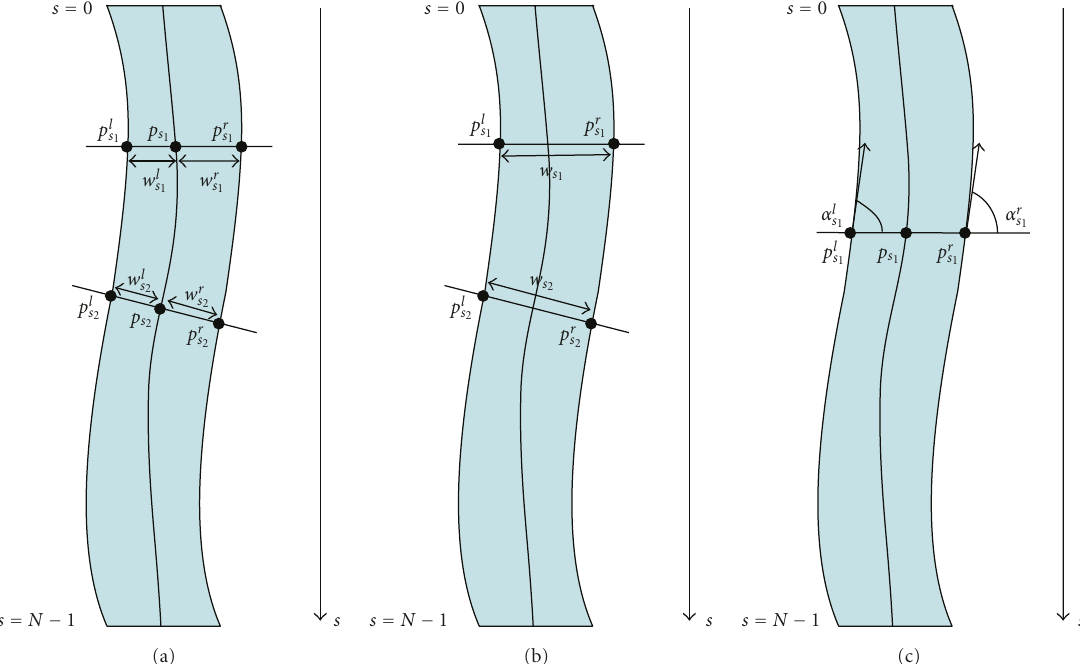
Figure 4: Definitions for the estimation of curvilinear properties. (a) Normal vector is estimated for every pixel p s of the skeleton. Then, the cross points between the normal vectors and the left and right borders define the p l calculated as the distance between the cross points and the pixel p s , where the normal vector is estimated. (b) For the elongation property, the method estimates w s as the distance between p l and p r . (c) For the parallelism property, the tangential vectors at pixels p l s s estimated. Then α l and α r are defined as the angles between those vectors and the normal vector at p s s s